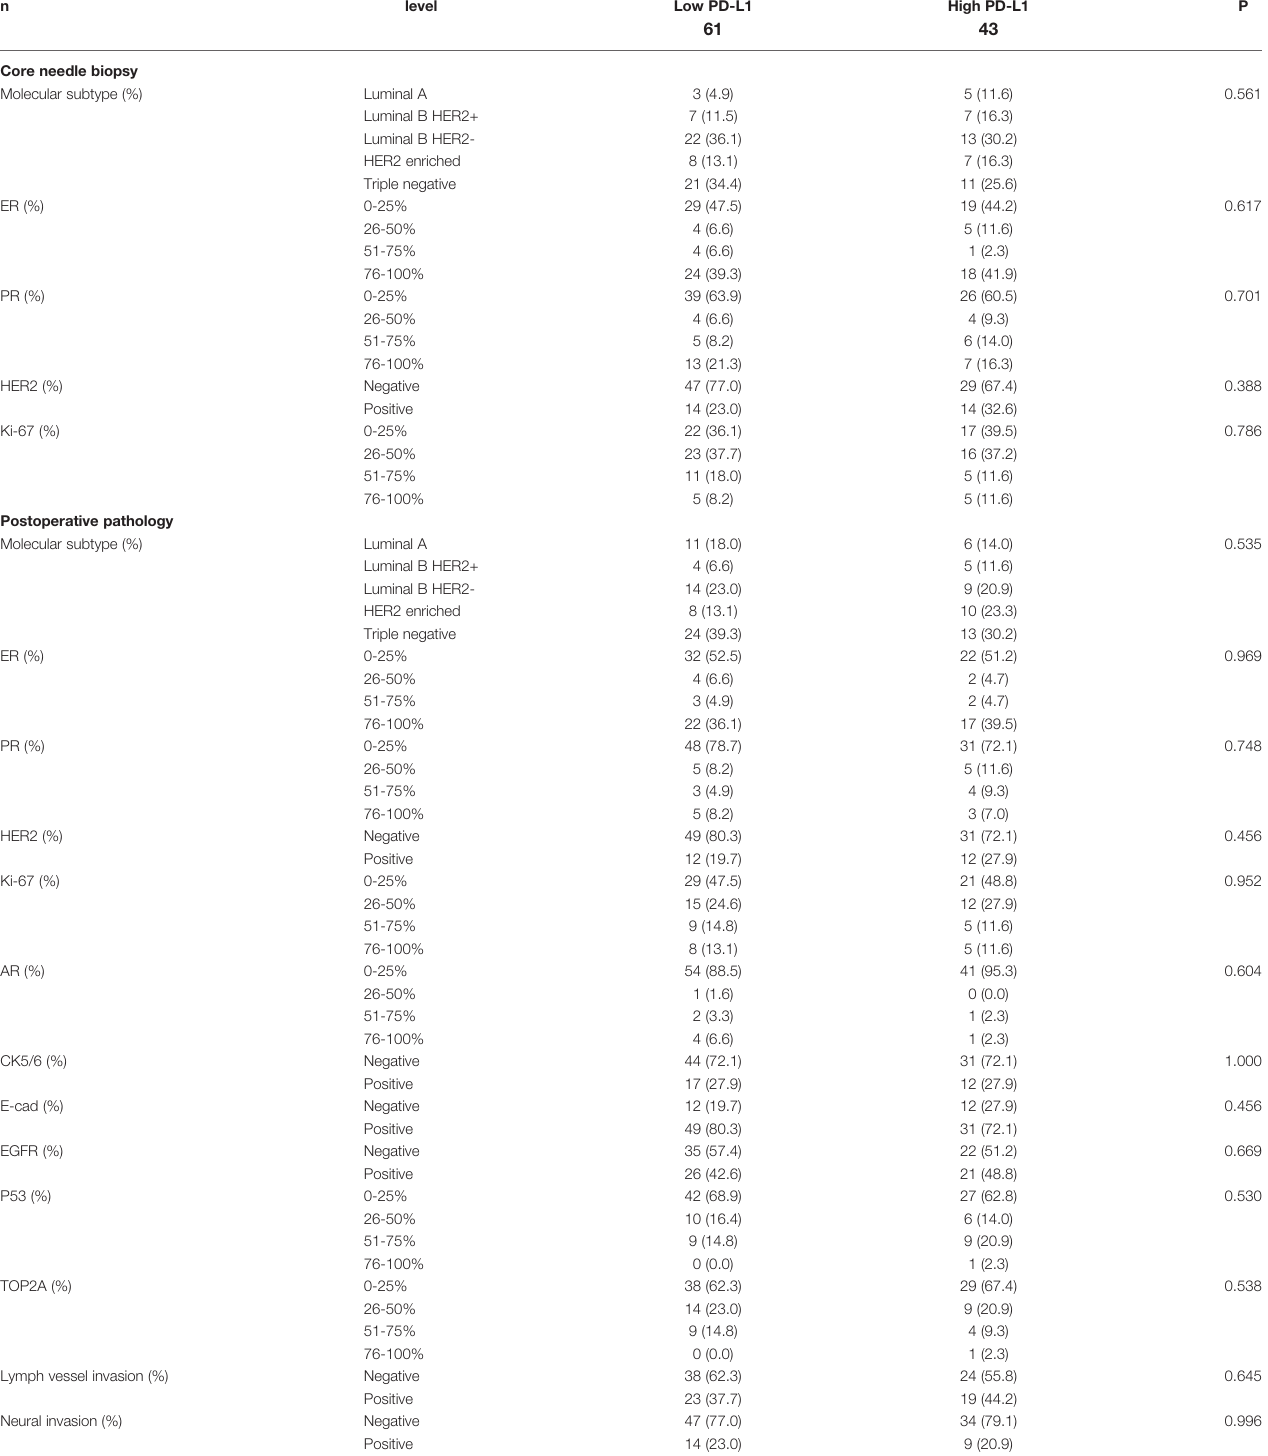
TABLE 2 | Patients ’ pathology parameters for all patients according to programmed cell death ligand-1